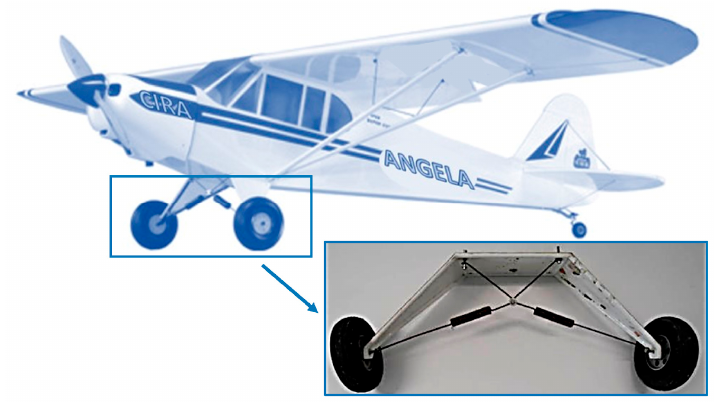
Figure 1. Drawing of a PiperPA-18 Super Cub aircraft. Detail: Front view of the test article: the leaf spring landing gear.